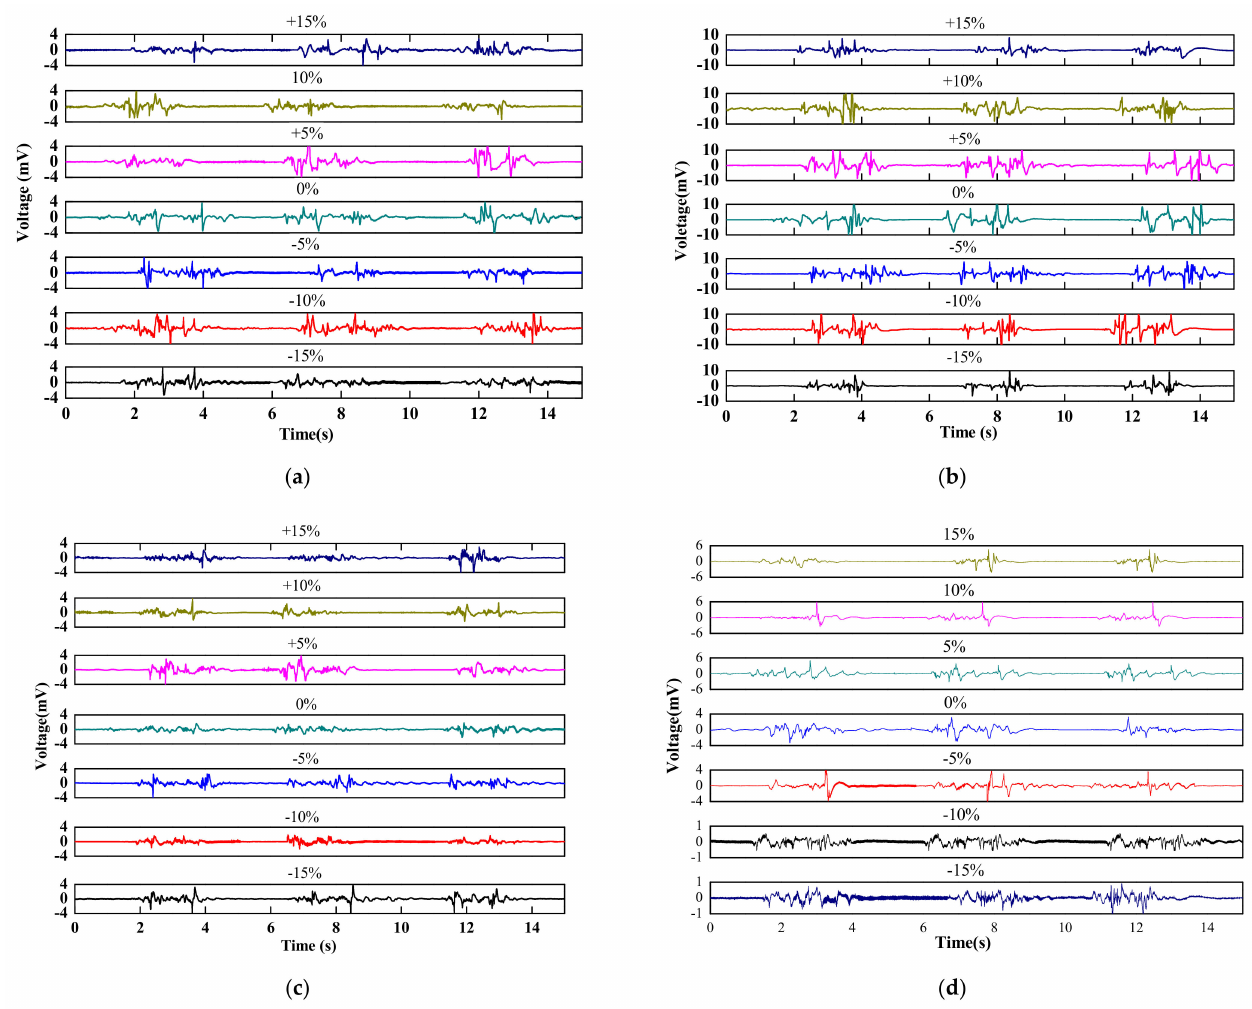
Figure 7. EMG signal of the lower limb in 7 slopes. ( a ) EMG signal of the rectus femoris; ( b ) EMG signal of the biceps femoris; ( c ) EMG signal of the tibialis anterior muscle; ( d ) EMG signal of the